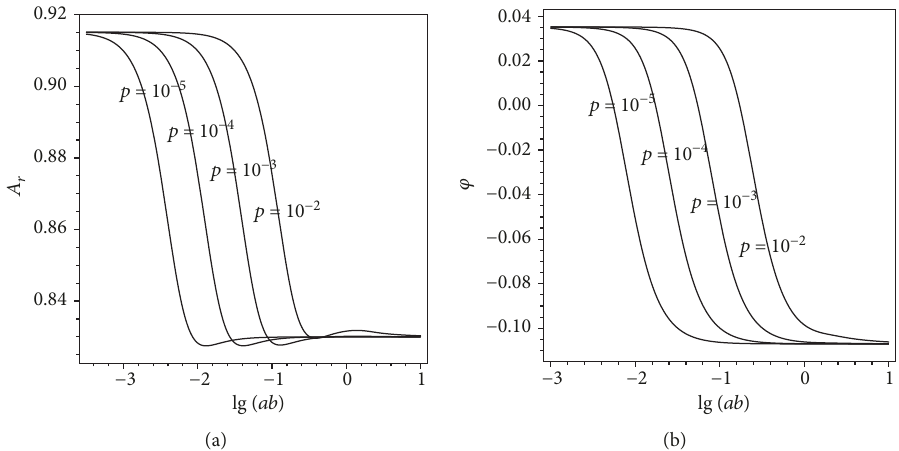
Figure 9: Changes of (a) amplitude ratio A for di ff erent values of p ( p = K ′ / K